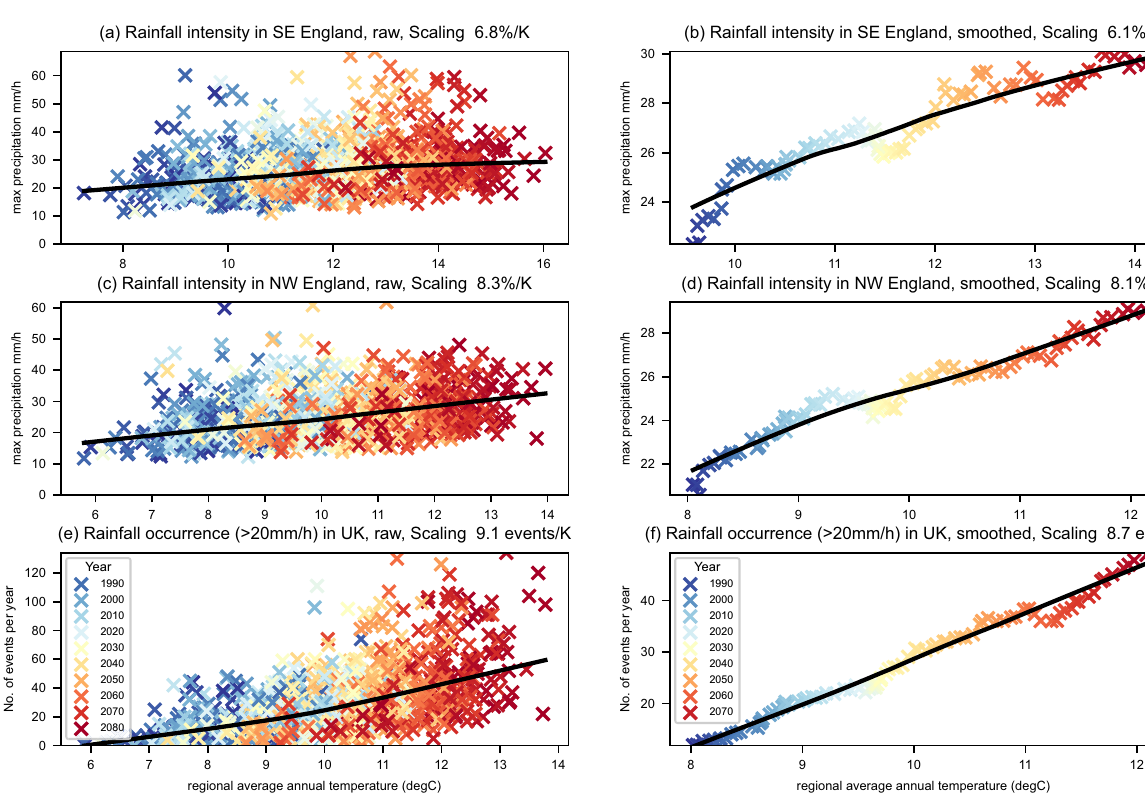
For raw data a , c , e , thereare 12points for eachyear,corresponding to the 12 CPM ensemble members. For smoothed data b , d , f , results are shown for the multi- member 10-year running mean. A lowess regression has been fi tted to the data (black line), and colours correspond to the year. Titles give the linear scaling coef fi